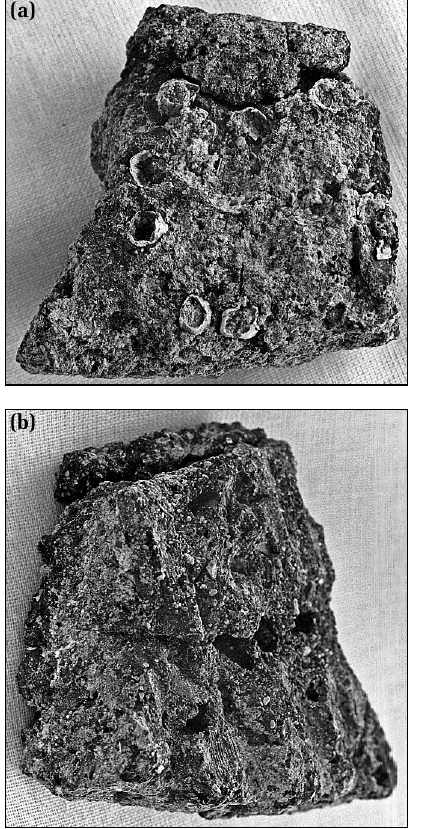
Figure 3 A slab of bitumen found at the H3 site: (a) the outer side with barnacles adhering to it; (b) the inner side showing parallel impressions of